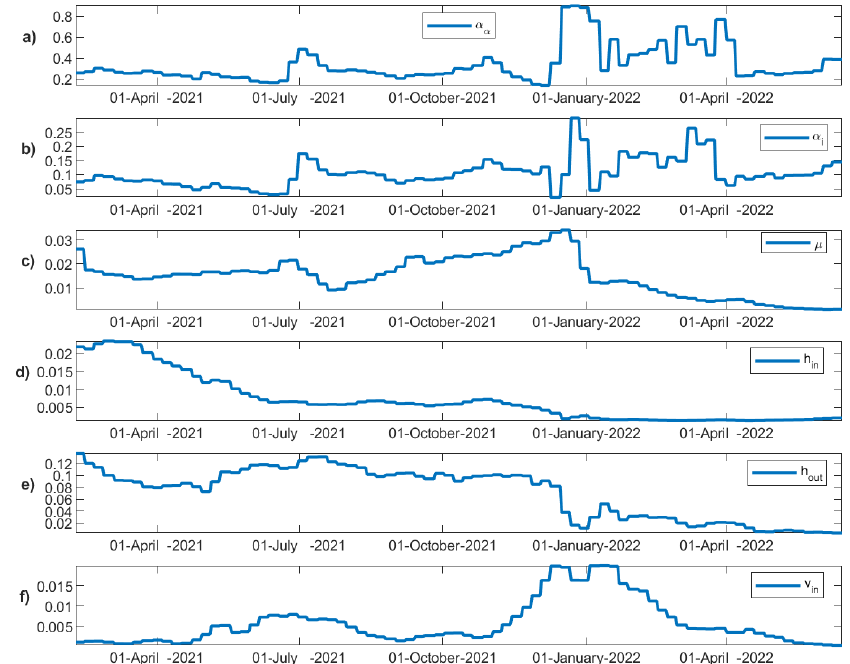
Figure 8. Fitted parameters over time for the fitting time period 1 February 2021–15 June 2022. ( a ) Transmission rate of asymptomatic individuals (a a ), ( b ) transmission rate of confirmed cases (a i ), ( c ) mortality rate ( µ ), ( d ) admission rate to hospitals (h in ), ( e ) discharge rate from hospital (h out ), and ( f ) vaccination rate over time (v in ).